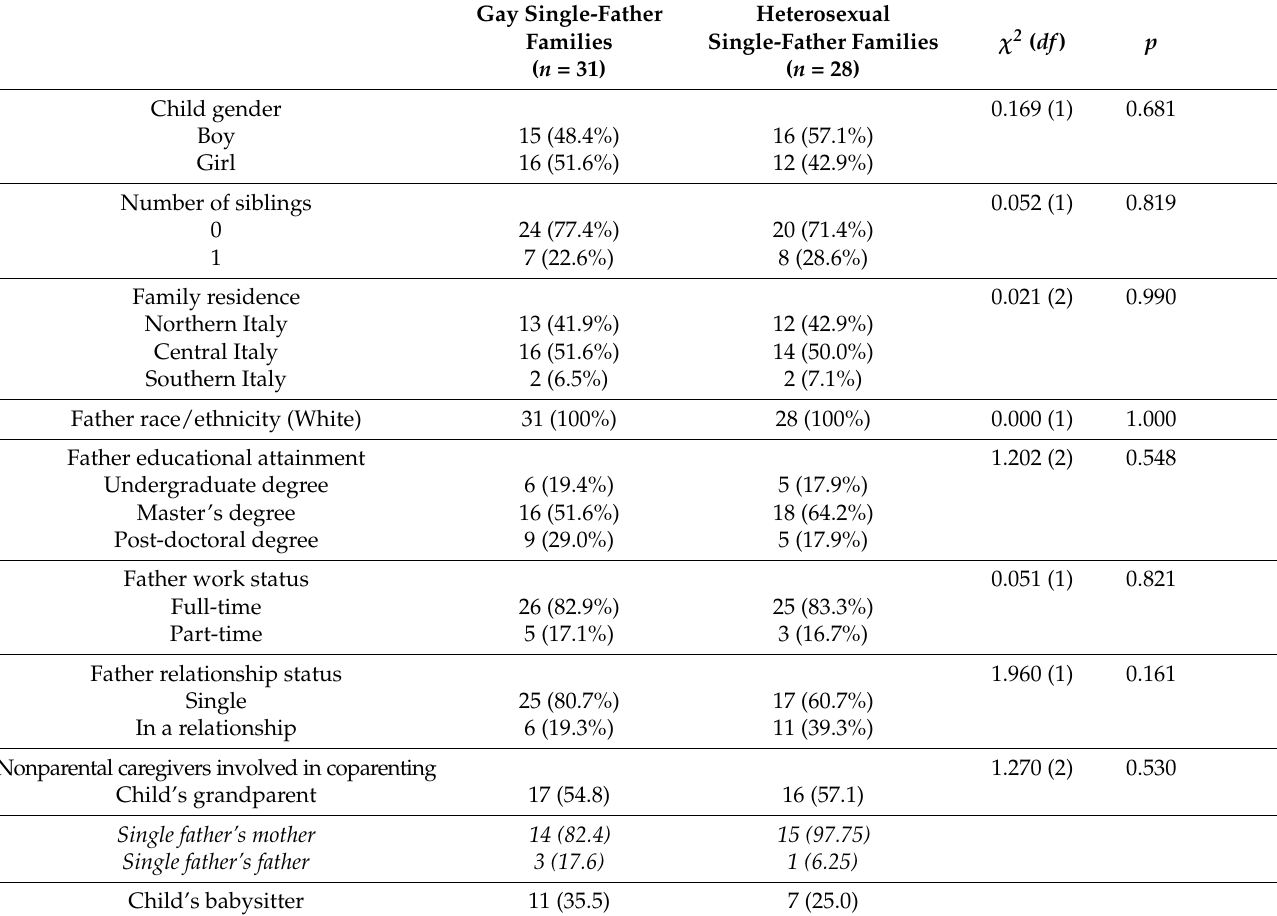
Table 1. Descriptive statistics of sociodemographic factors by family type ( N =